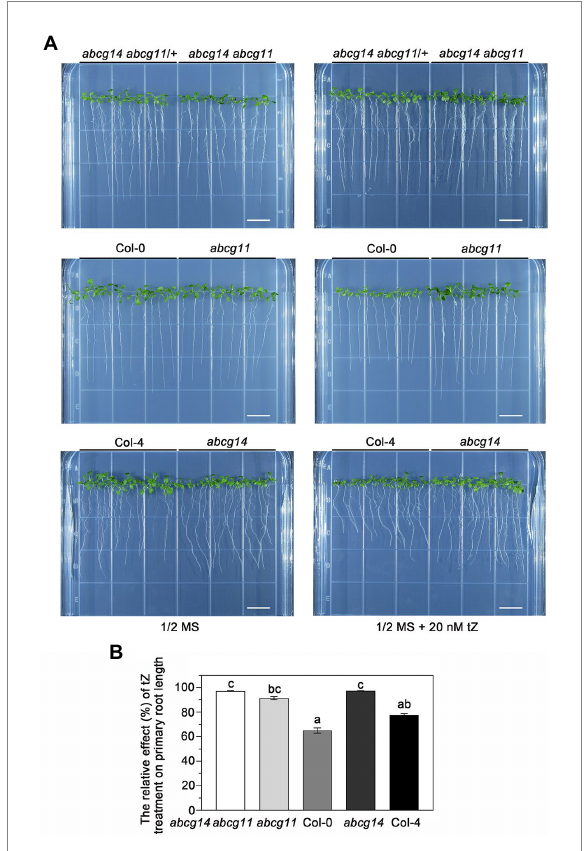
FIGURE 9 The abcg14 abcg11 double knockout mutant is similar to abcg11 and abcg14 single mutants in root growth in response to cytokinins. (A) Seedlings grown with or without 20 nM trans - zeatin (tZ) treatment for 12 days under long-day conditions (16 h light/8 h dark). The photographs are representatives of four independent experiments. Scale bars, 1 cm. (B) Relative effect of tZ treatment on primary root growth. The relative effect was calculated as primary root length under tZ treatment normalized by that of the control treatment. Data are shown as means ± SE from four independent experiments. Different letters represent significant differences, as determined by one- way ANOVA ( p <